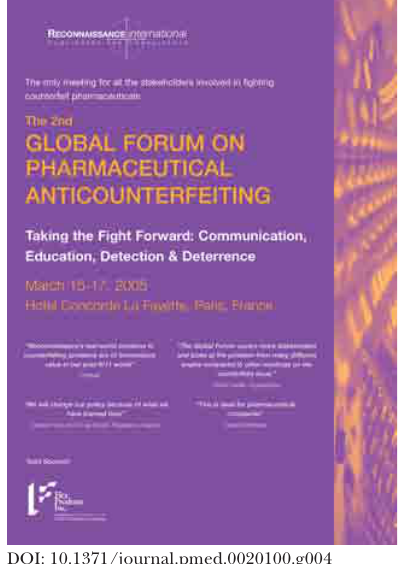
Figure 3. Poster Advertising the Second Global Forum on Pharmaceutical Counterfeiting (Figure: Ian Lancaster, Reconnaissance